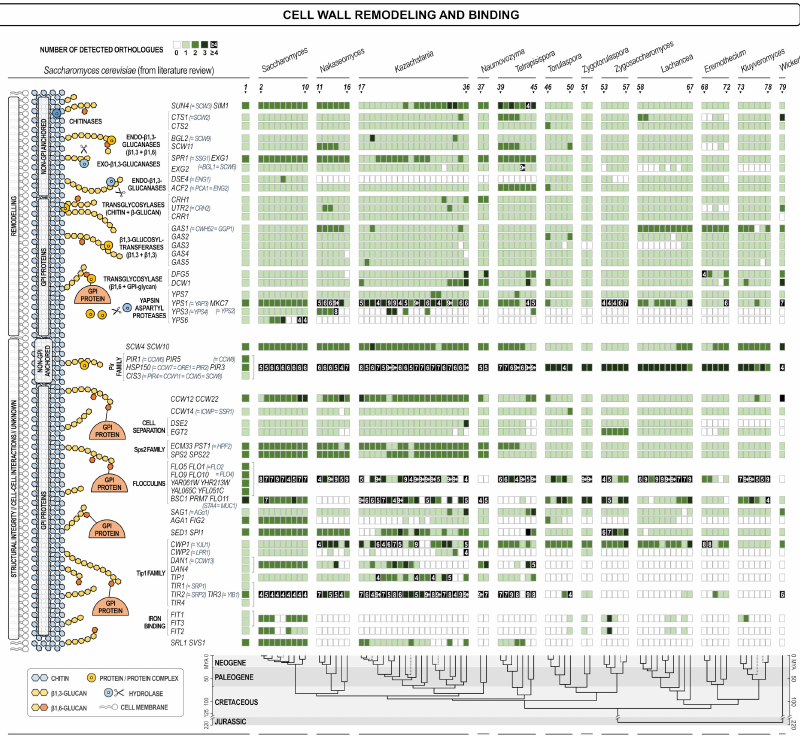
Figure 4. Heat map of orthologues of S. cerevisiae genes coding for proteins that reside in the cell wall. Every gene is presented in one row, while every yeast (see the legend of Figure 1) is presented in one line. The scheme of the cellular process with the site in which the product of each gene is involved is shown on the left. The intensity of the color of every square is proportional to the number of orthologues found as depicted in the inset legend. White square means no orthologue has been found. The lower part of the figure presents the evolutionary chronogram of each